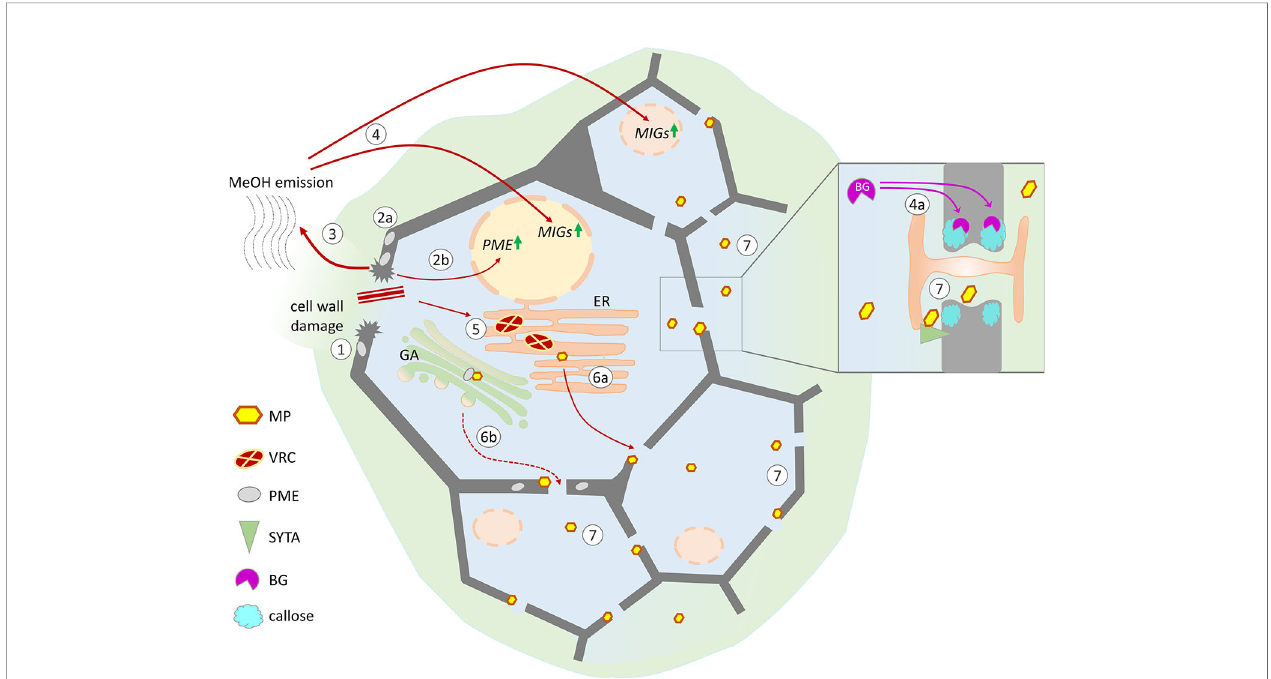
FIGURE 2 | Possible mechanisms of cell conditioning by nonviral factors induced by cell wall trauma and the speci fi c effects of virus-directed MP, leading to the creation of favorable conditions for the intercellular spread of infection. Cell wall damage (1) results in the activation of pre-existing PME (2a) as well as PME expression (2b), leading to the increased release of gaseous methanol (3). Methanol-induced genes (MIGs), including b -1,3-glucanase (BG) and NCAPP, are stimulated by methanol (4). MIG induction activates intercellular transport increasing the Pd SEL: BG degrades callose around Pd (4a), and NCAPP is believed to be indispensable for MP functioning. TMV penetrates into the cell through damage to the cell wall, starts to replicate, and forms viral replication complexes (VRCs) on ER membranes (5). MP translated from genomic and subgenomic vRNAs is delivered to the Pd in a tight connection with ER membranes (6a) and possibly via the Golgi apparatus in a PME-mediated manner (6b). As MP colocalizes with SYTA in the VRC and Pd, the mechanisms of SYTA transport to the Pd may in fl uence MP delivery. MP may participate in the displacement of negative regulators from the Pd structure and the activation of positive regulators ( e.g. , SYTA). (7) Moving independently of the genomic viral RNA to the neighboring cells MP increases Pd SEL and creates favorable conditions for the intercellular spread of